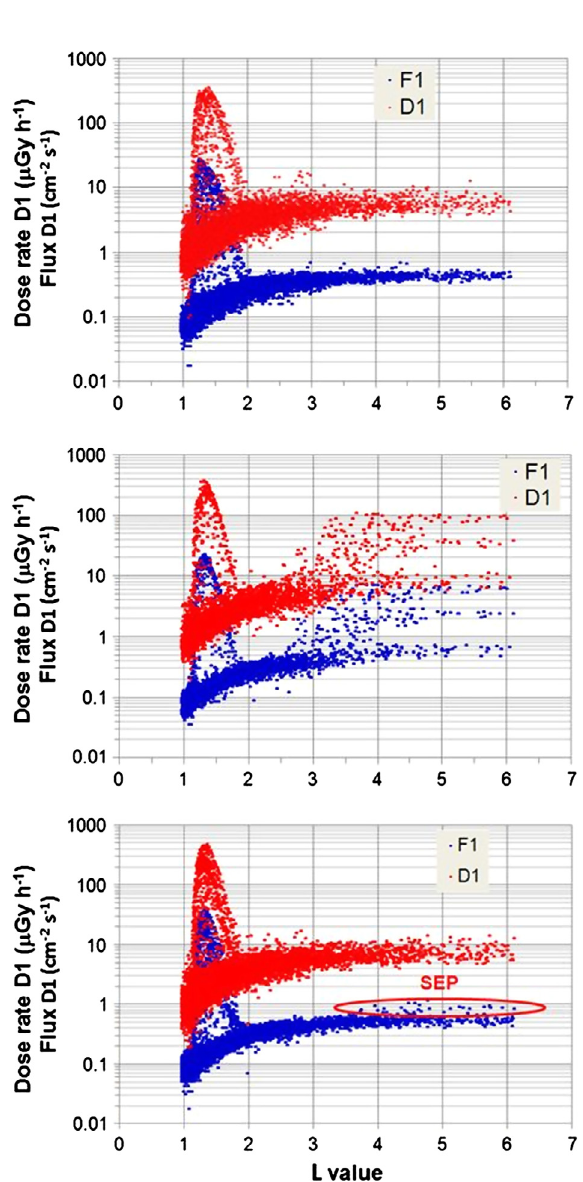
Fig. 6. Distribution of Liulin-5 particle flux F1 (blue) and dose rate D1 (red) as a function of L -value. Scatterplots: upper (during quiet conditions), middle (during the SEP events in March 2012), bottom (during the SEP event in May 2012). Upper and middle scatterplots taken from Semkova et al. (2013c).